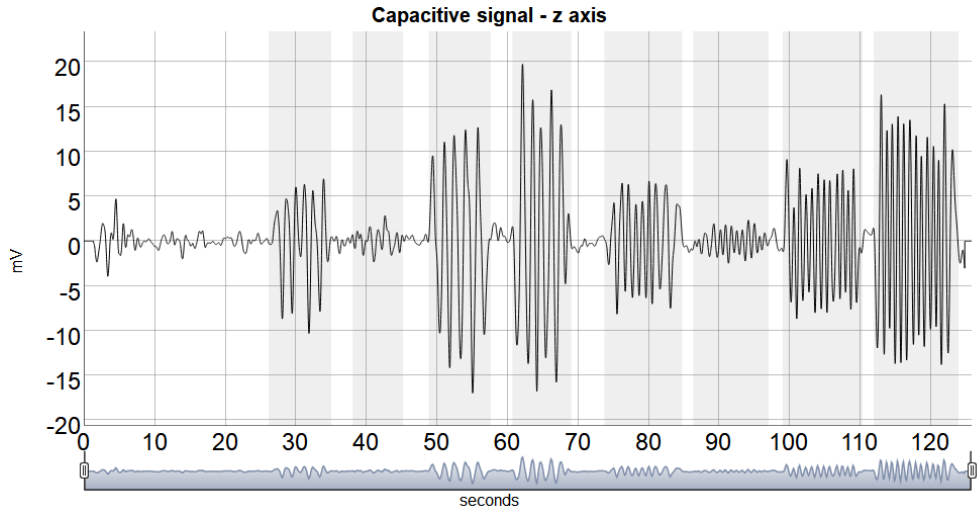
Figure 6. Typical hand movement detections A shadow indicates the tasks on the proximal-distal (z − axis).